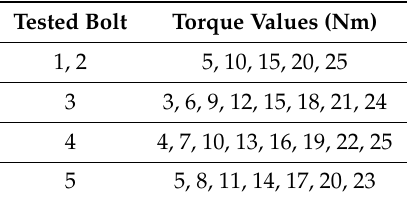
Table 2. Description of test